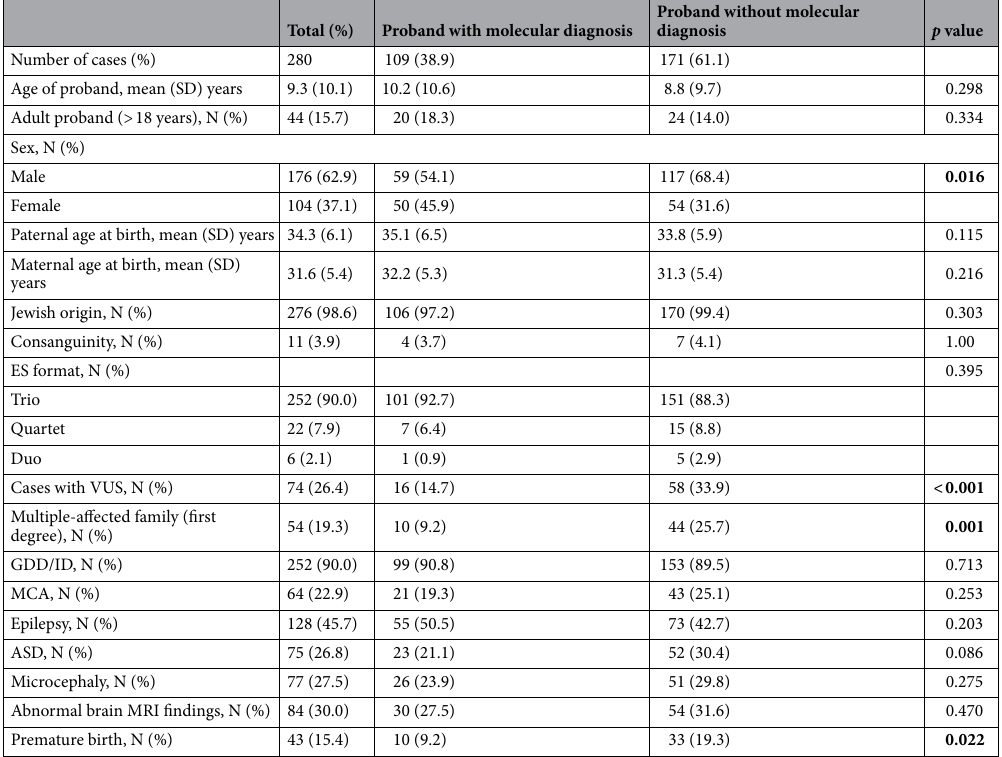
Table 1. Demographic and clinical characteristics of 280 probands with GDD/ID and/or MCA for which exome sequencing was pursued, and comparison between probands with and without a subsequent molecular diagnosis. Statistically significant values ( p < 0.05) are given in bold. ASD, autism spectrum disorder; ES, exome sequencing; GDD, global developmental delay; ID, intellectual disability; MCA, multiple congenital anomalies; MRI, magnetic resonance imaging; N, number; NDD, neurodevelopmental delay; SD, standard deviation; VUS, variant of uncertain